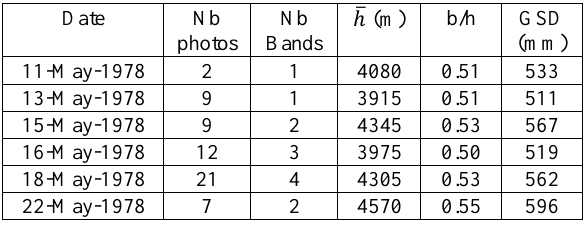
Table 1. Details of 1978 archive photographs available on http://remonterletemps.ign.fr on Cirque de Salazie, La Réunion, used in this study. All photos were shot with an unknown camera equipped with a UAgI 153.23 mm lens (serial number 6023). ℎ̅ is the height above ground average of the camera centers. b/h is the average overlapping of the camera and the ground sampling distance (GSD) (0.02. ℎ̅ /f mm). Taking the 38 pictures with multiview stereo b/h equals to 0.49 and GSD 557 mm.